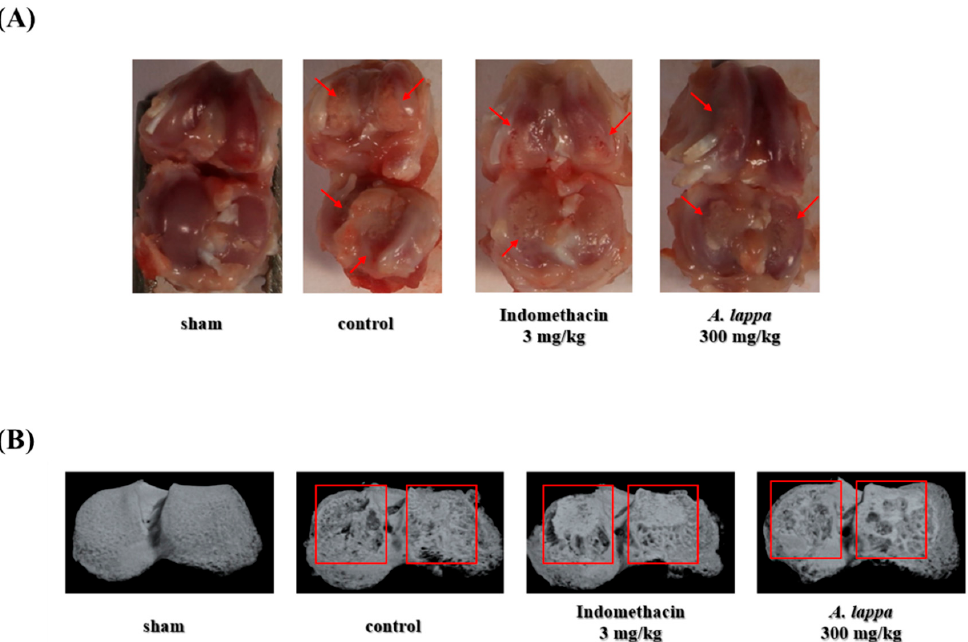
Figure 3. Observation of the structural properties of cartilaginous bone of Monosodium iodoacetate (MIA)-induced OA rats. ( A ) Photograph of the right knee joints of the rats and ( B ) micro-CT images of the right tibia of the rats. Micro-CT scan was performed using SKY scan 1176 micro-CT system with these settings—X-ray source: 70 kV/355 µA; exposure time: 800 ms; pixel size: 8.9 µm; filter: 0.5 mm aluminum; pixel size: 8.9 µm; exposure time: 800 ms; rotation angle: 180° rotation angle with rotation steps of 0.4°.